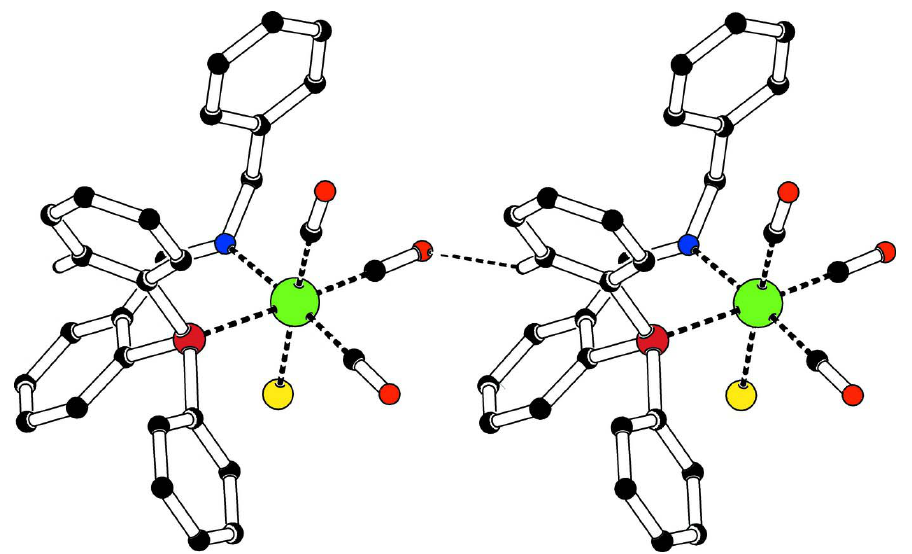
Figure 2 Excerpt from a cell plot depicting the intermolecular hydrogen-bond between H22 and the carbonyl oxygen atom O3 of a neighboring complex. The H atoms not involved in hydrogen bonding and the dichloromethane molecules have been omitted for